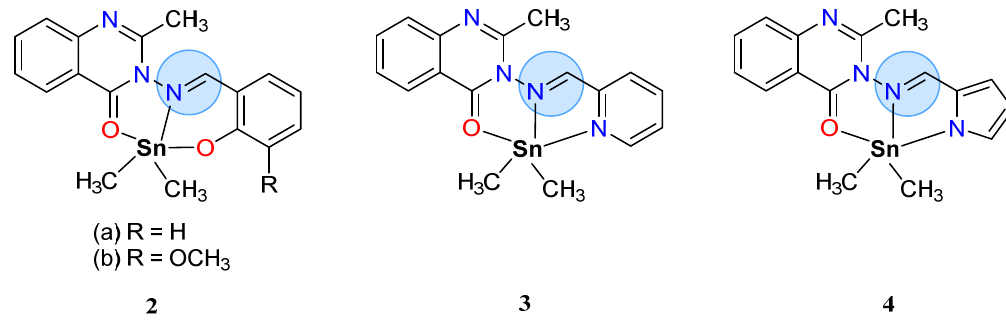
Figure 4. Organotin(IV) complexes with ligands derived from 4(3 H ) ‐ quinazolinone. More recently, a series of sixteen pentacoordinated diorganotin(IV) complexes with dianionic tridentate SB hydrazones (ONO) as ligands (complex 5 ) was reported (Figure 5) [83]. The complexes were tested against four bacterial strains, the Gram ‐ positive B. cereus and S. aureus, and the Gram ‐ negative E. coli and P. aeruginosa , as well as the three fungal strains A. flavus , A. niger , and C. albicans . As in previous reports, the complexes were more